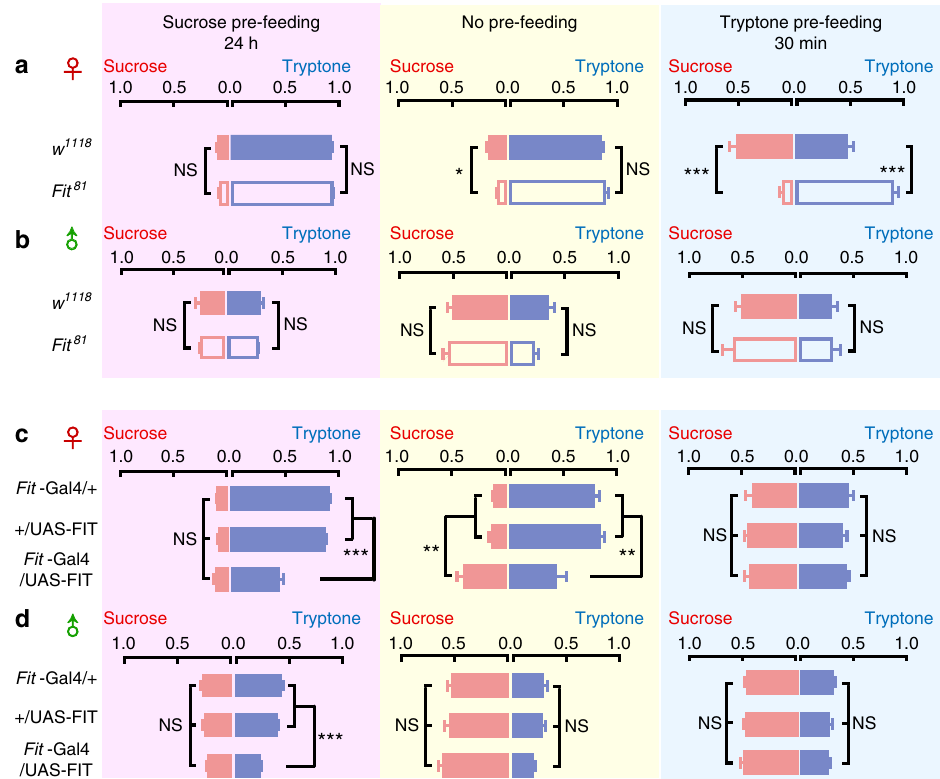
Figure 4 | Choice ratio for protein food is increase in Fit 81 mutant flies and decreased in FIT-overexpressing flies. ( a , b ) After tryptone pre-feeding, the CR for protein and sugar food significantly decreased and increased, respectively, in WT but not Fit 81 mutant flies. Flies were kept under normal fed condition (middle row in yellow), and pre-fed with either sucrose (left row in pink) or tryptone (right row in blue). n ¼ 6–15. Data were analysed by unpaired Student’s t -test. ( c , d ) Overexpression of FITsuppressed protein CR, when compared with their parental control flies. n ¼ 6. One-way ANOVA, LSD’s post hoc test. * P o 0.05; ** P o 0.01; *** P o 0.001. NS indicates no statistical significance. The data are mean ±